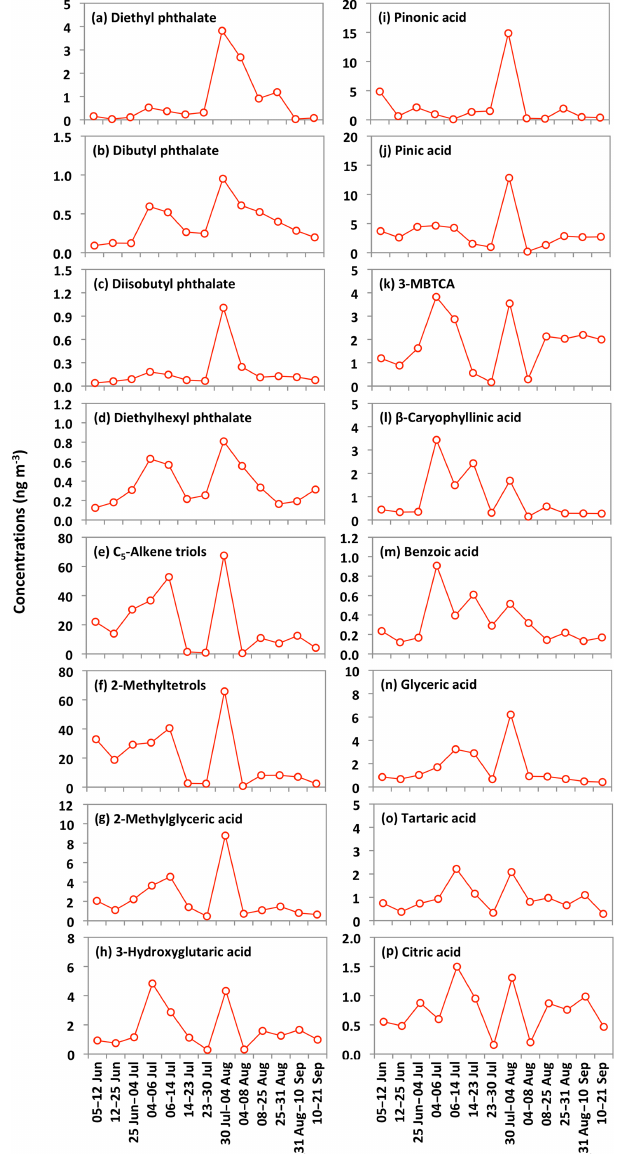
Figure 11. Temporal changes in the concentrations of phthalate es- ters and other organic compounds in the Alaskan